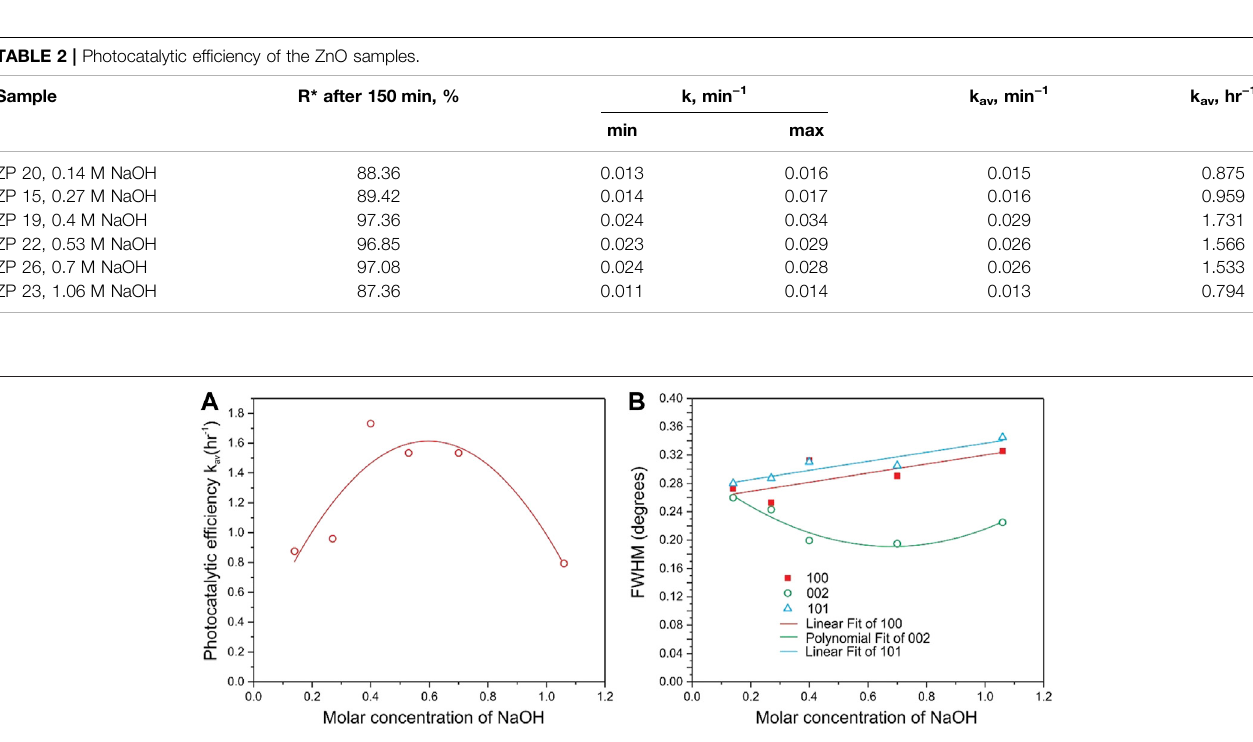
FIGURE8| Photocatalyticactivity (A) andhalf-widthofX-rayre fl ections100,002,and101 (B) ofthesynthesizedsamplesdependingonthemolarconcentrationof NaOH in the growth solution.